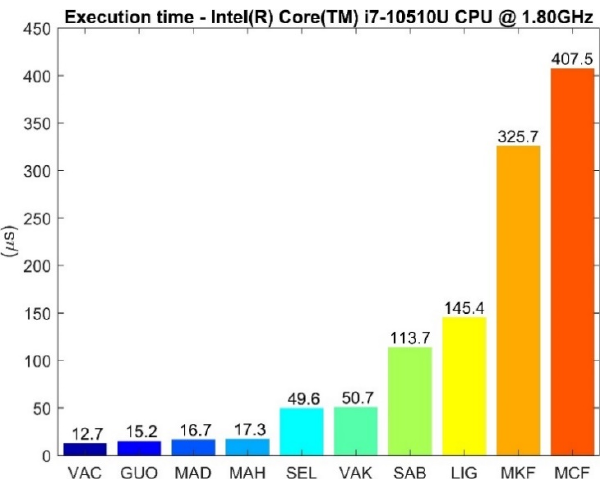
Figure 5. Execution time needed for a single update step by each SFA.